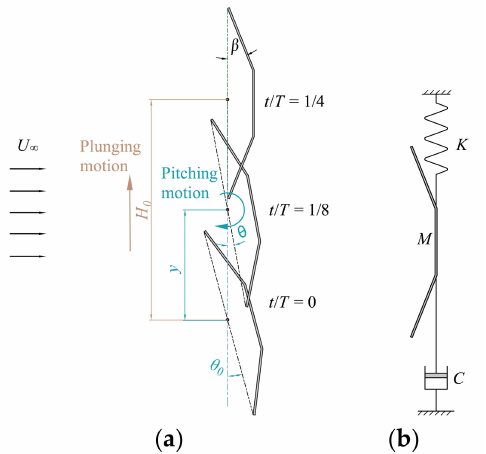
Figure 2. Schematic of the prescribed double-DOF bent plate and the flow-induced single-DOF oscillator based on a bent plate. ( a ) Prescribed motion ( b ) Passive